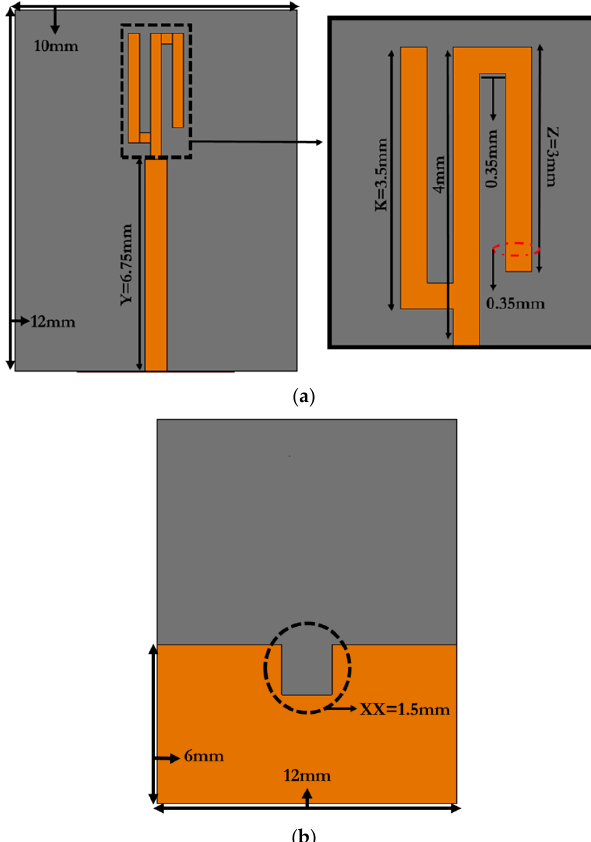
Figure 1. Proposed Antenna ( a ) Front ( b ) Back.